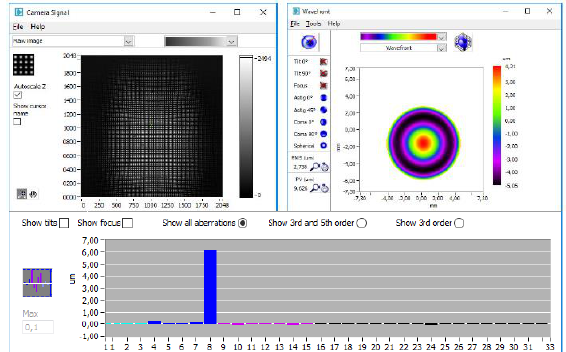
Fig. 7. Camera signal, wavefront and modal decomposition of a miniature aspheric lens.